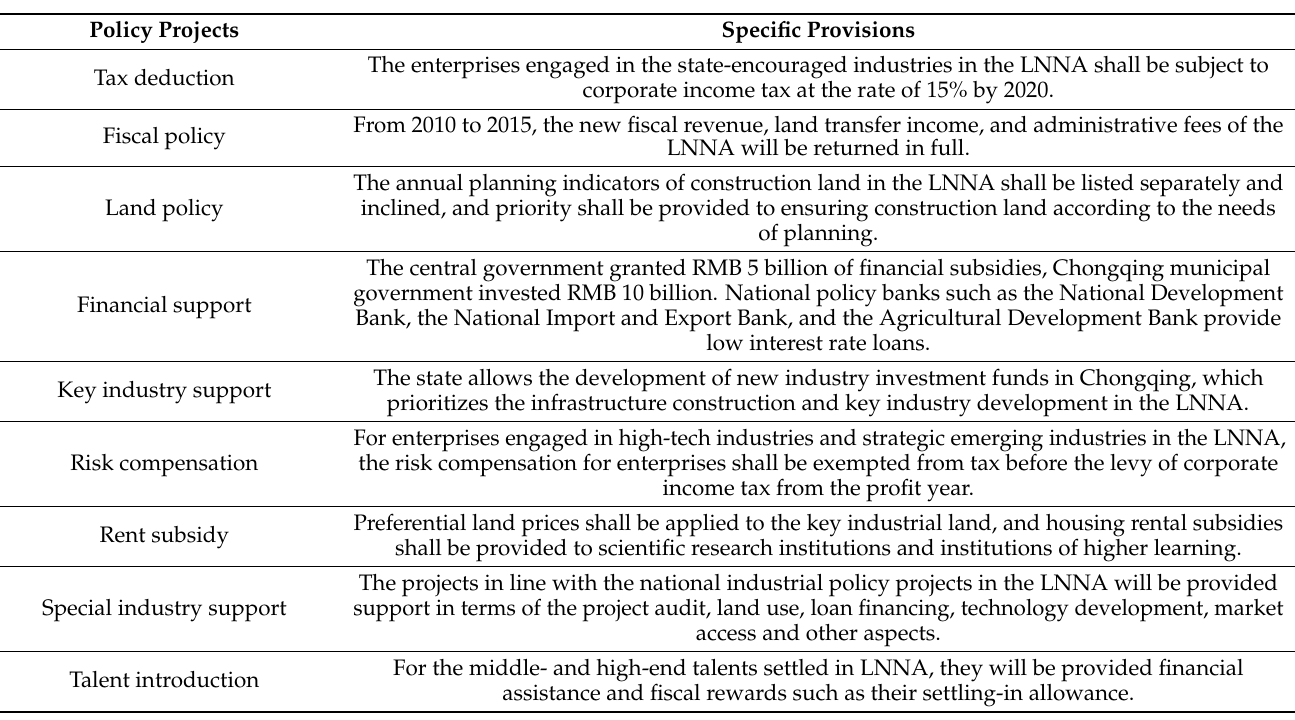
Table 3. Special policy experiments for the LNNA (source: the author edited and complied from interviews in the field work (August, 2018) with local officials, and information derived from official website of Liangjiang National New Area (http://www.liangjiang.gov.cn/ (accessed on 20 August